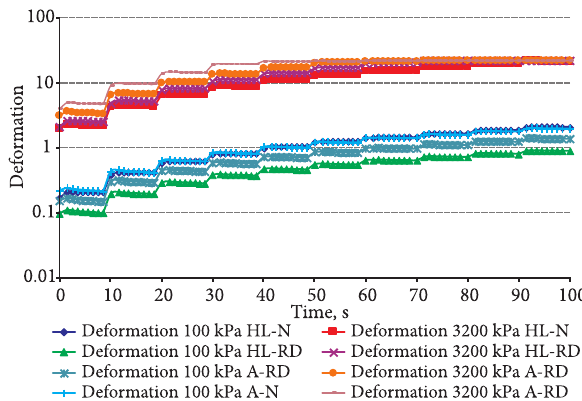
Fig. 7. Strain changes of the extracted bitumen from SMA pavement samples dependent on dynamic stress level